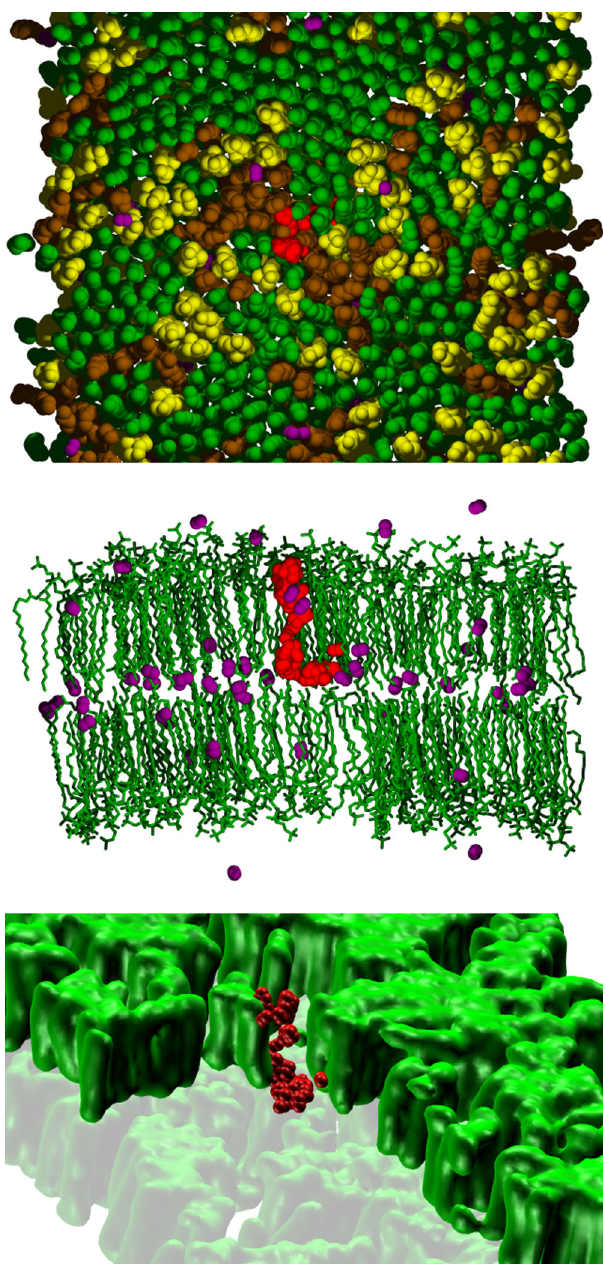
Fig. 1 Simulation snapshots of a single oxygen entering the liquid ordered phase. The bilayer is represented by the lipid con fi guration at the beginning of the time sequence, and waters and ions are removed in all panels. Positions of the diffusing oxygen (in red) are spaced at 5 ps intervals over 500 ps. Top panel: a top-down view with head groups removed to highlight the chain packing (DPPC green, DOPC brown, and cholesterol yellow). Middle panel: side-view with DOPC and cholesterol removed, and with other oxygen molecules from the initial con fi guration (purple); atoms in only half of the box are included for clarity. Bottom panel: the same set of frames with the single oxygen and DPPC (including the head groups and smoothed) with part of the top lea fl et removed and the bottom lea fl et in semitransparent to highlight the substructure of the